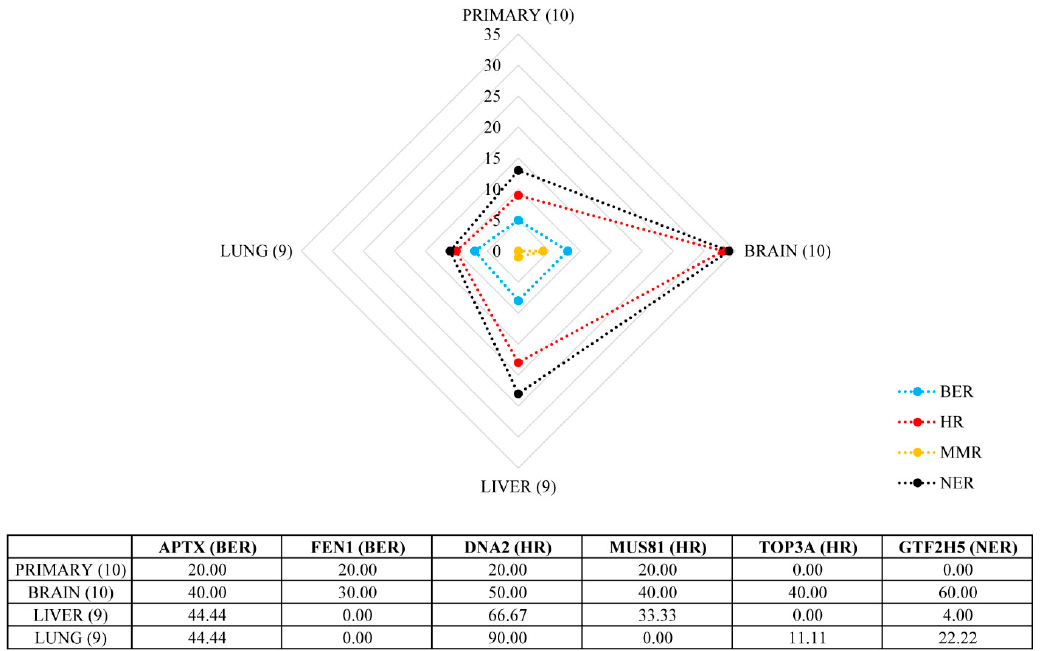
Figure 3. Copy number loss (CNL) frequency in different melanoma metastases affecting genes coding proteins in DDR subpathways. Radar chart represents the CNL frequency in primary melanomas and visceral metastases. In brackets, we indicated the count of samples resected from primary tumors and a given metastatic site. The vertical axis represents the number of genes altered in any of the DDR subpathways. Table shows the frequency (percentage) of the TOP6 DDR genes affected in melanoma. Abbreviations: DDR, DNA damage repair; BER, base excision repair; HR, homologous recombination; MMR, mismatch repair, NER, nucleotide excision repair.